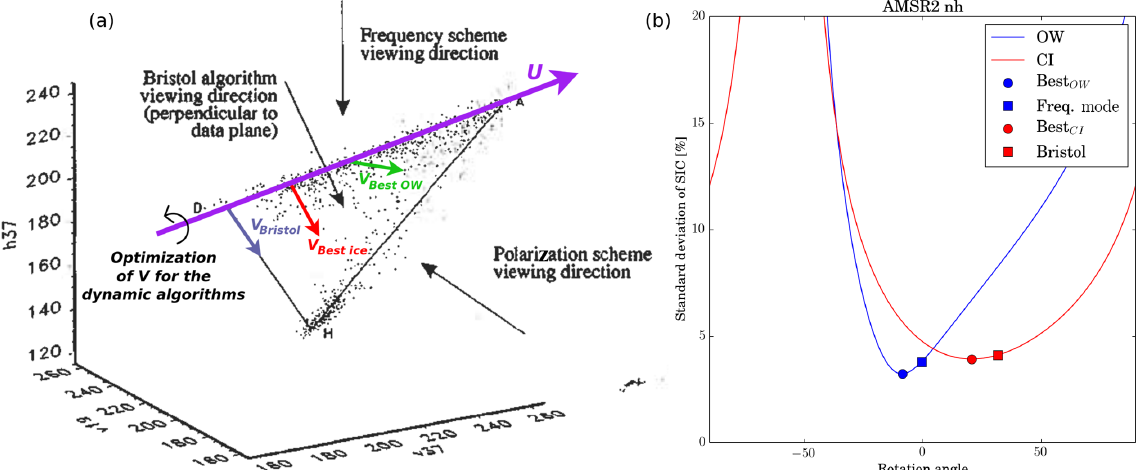
Figure 4. (a) Three-dimensional diagram of open-water (H) and closed-ice (ice line between D and A) brightness temperatures in a 19 V , 37 V , 37 H space (black dots). The original figure is from Smith (1996). The direction U (violet, sustained by unit vector u defined in Sect. 3.4.3) is shown, and vectors v Bristol (blue), v Best-ice (red), and v Best-OW (green) are added, as well as an illustration of the optimization of the direction of V for the dynamic (self-optimizing) algorithms. (b) Evolution of the SIC algorithm accuracy for open-water (blue) and closed-ice (red) training samples as a function of the rotation angle θ in the range [ − 90 ◦ ; 90 ◦ ]. Square symbols are used for the BFM (frequency mode) and BRI (Bristol) algorithms. Disk symbols locate the new, self-optimizing